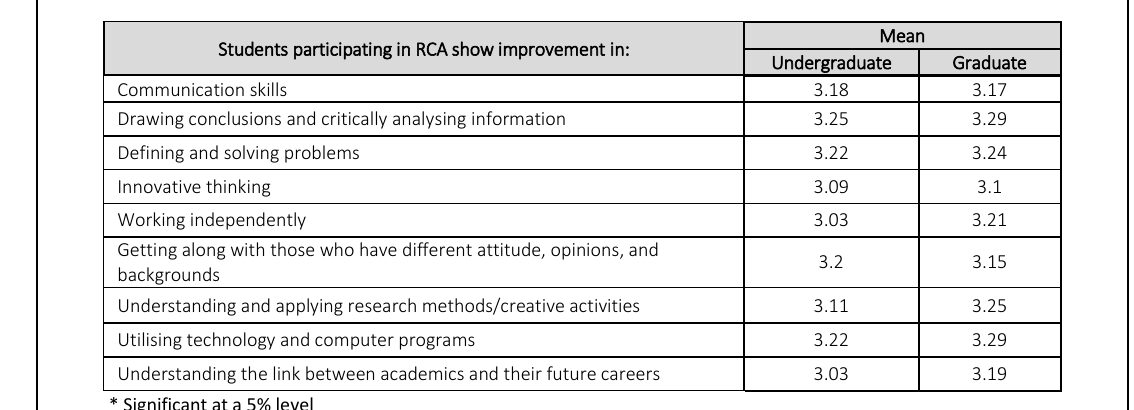
Table 2: Faculty ratings across colleges for benefits of RCA Students participating in RCA show improvement in: